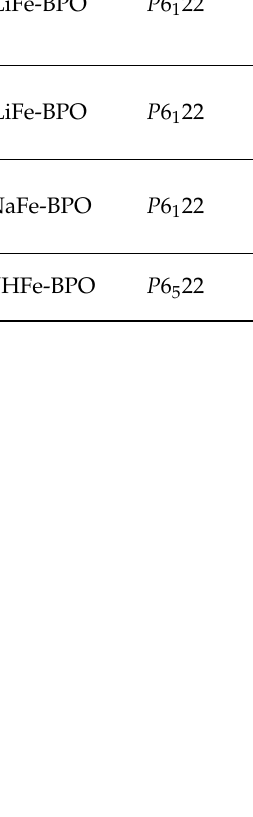
Table 6. Electrochemical performance of the BO 33 − doped LiFeSiO 4 cathode materials.